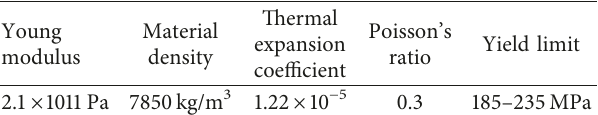
Figure 14: The finite element whole model of the overall main structure of the electrostatic precipitator. Table 1: The main structure material properties of the electrostatic precipitator.